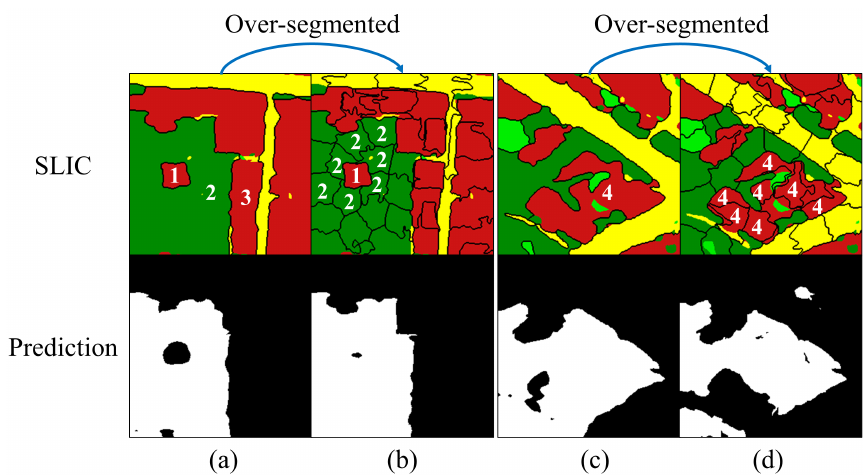
Figure 11. Two examples are provided to illustrate how the segmentation scale affects the construction of topological relations. In some cases, over-segmentation is beneficial for describing the topological relations of small objects. For instance, the “surrounding” relationship in ( b ) can be better expressed when the sample in ( a ) is over-segmented. However, describing the actual topological relations of large objects becomes more challenging when they are over-segmented. For example, ( d ) is the over-segmentation of ( c ). Since the topological relationship of node 4 is incorrectly expressed as being surrounded by buildings, the segmentation result of ( d ) is unsatisfactory.